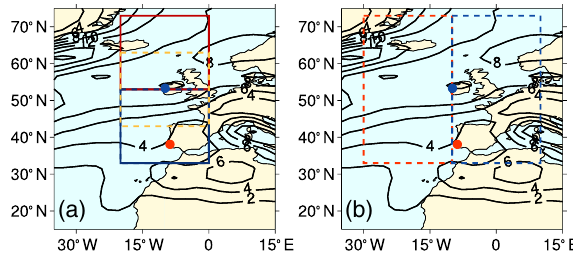
Figure 1. Maps showing the five regions where cyclones pass near Mace Head (blue dot) which are associated with O 3 measurements from Mace Head. (a) North region 53–73 ◦ N, 20 ◦ W–0 ◦ (red box); Center: 43–63 ◦ N, 20 ◦ W–0 ◦ (yellow box); and South: 33–53 ◦ N, 20 ◦ W–0 ◦ (blue box). (b) West: 33–73 ◦ N, 30–10 ◦ W (orange box); East: 33–73 ◦ N, 10 ◦ W–10 ◦ E (blue box). In addition, track den- sity distribution for cyclones from ERA-Interim for MAM 1979– 2011 (black contour lines; interval of two cyclones per month per 5 ◦ spherical cap) and Monte Velho (orange dot) are